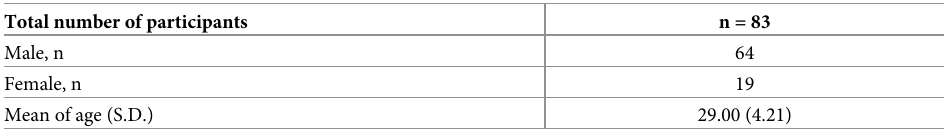
Table 2. Basic characteristics of